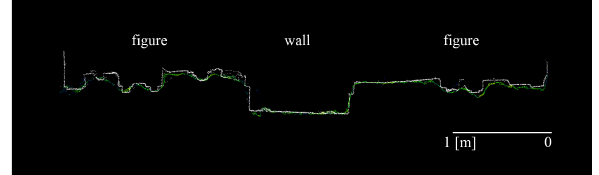
Figure 9: Horizontal section through a detail area showing differences in level of accuracy between uncomplex